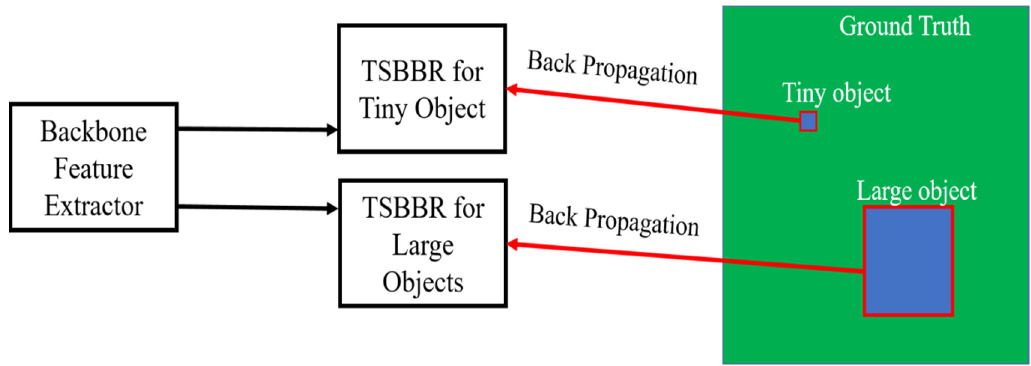
Figure 4. Proposed conditional back-propagation mechanism. According to the ratio of the object short side and corresponding frame side of the ground-truth, TSBBRs would only produce losses on their prior set targets. These losses would be collected and summed up. Based on the summed losses, weights in model would be updated simultaneously.